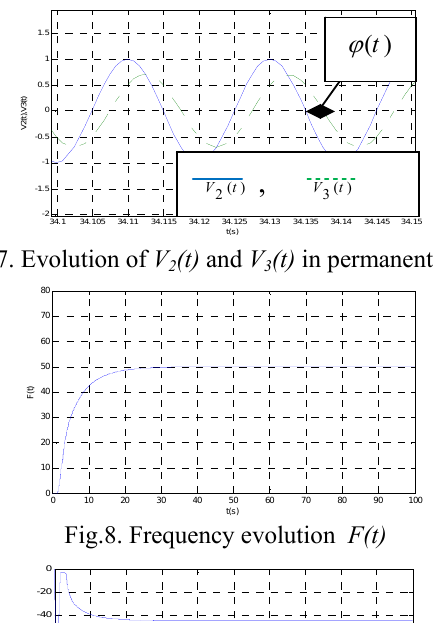
Fig.9.a. Phase evolution